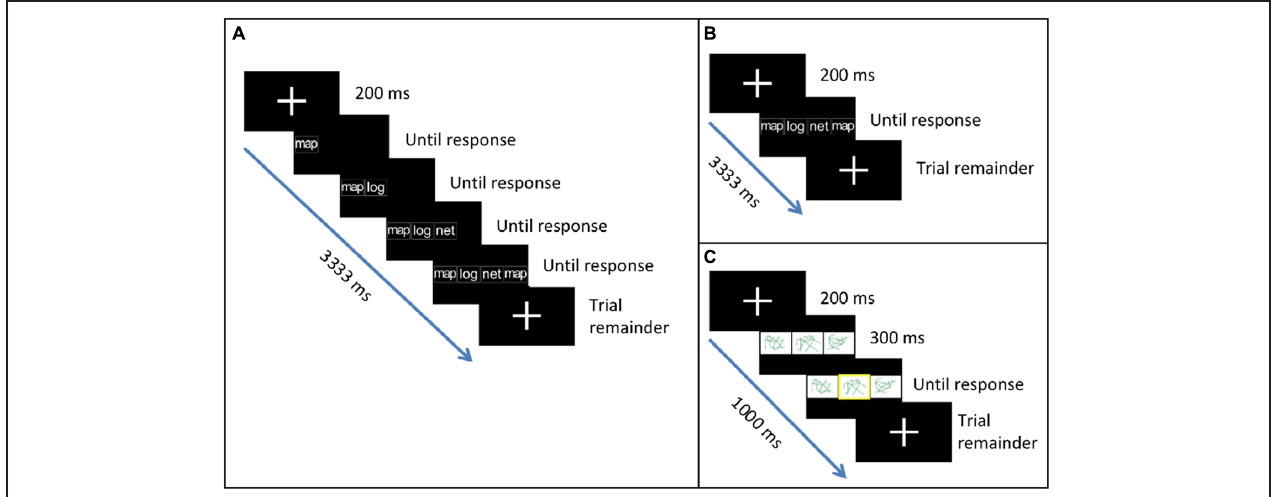
FIGURE 1 | Tasks used in the study. (A) In the Consecutive task, participants replicated a sequence of syllables or words using button presses. Items in the sequence appeared one after another. (B) In the Concurrent task, items in the sequence appeared all together at once. (C) In the Baseline task, participants indicated which abstract line drawing was